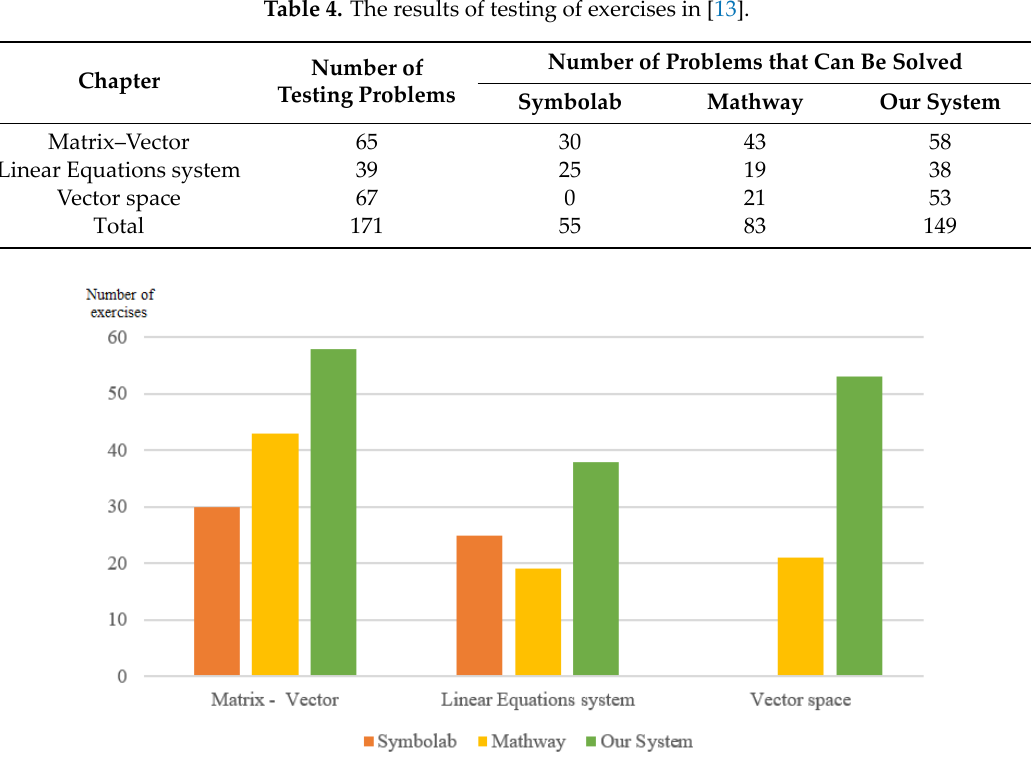
Figure 6. Results of testing of Symbolab, Mathway, and our system.